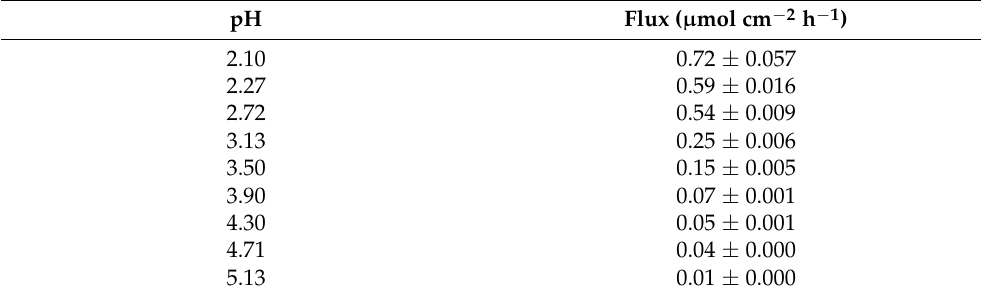
Table 14. Flux ± standard deviation of 14.48 mM solutions of SA across human skin at a range of pH values (experiments n = 2, values represent the mean ± S.E.) Adapted with permission from [47], Elsevier,